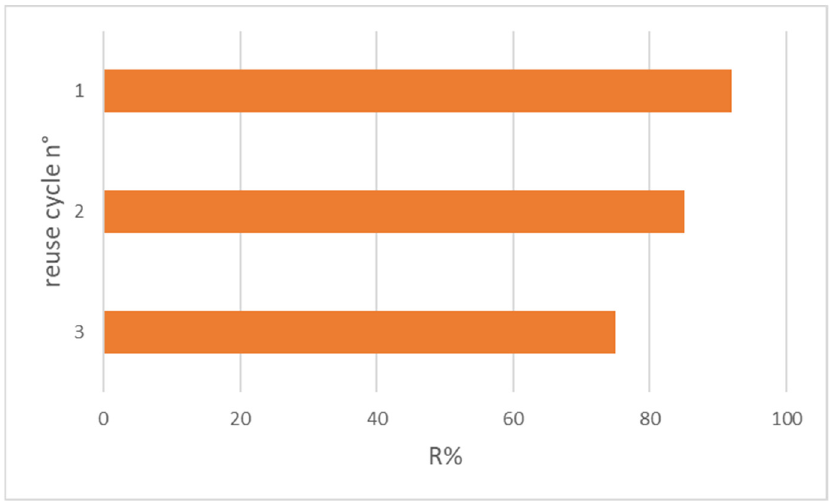
Figure 10. OFL removal after three reuse cycles with HNT/Fe 3 O 4 -C (Experimental conditions: sorbent 20 mg, 10 mL tap water, OFL initial concentration 10 µg L − 1 ).